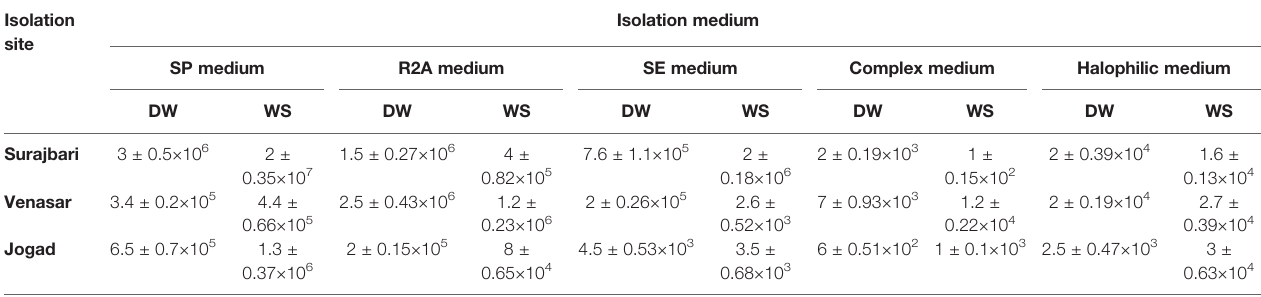
TABLE 2 | Colony forming units cultivated prokaryotic population in different sites of LRK. Isolation